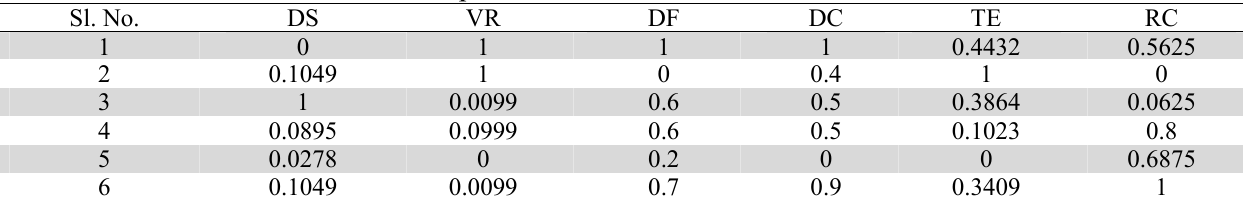
Normalized decision matrix for example 3 Sl. No.